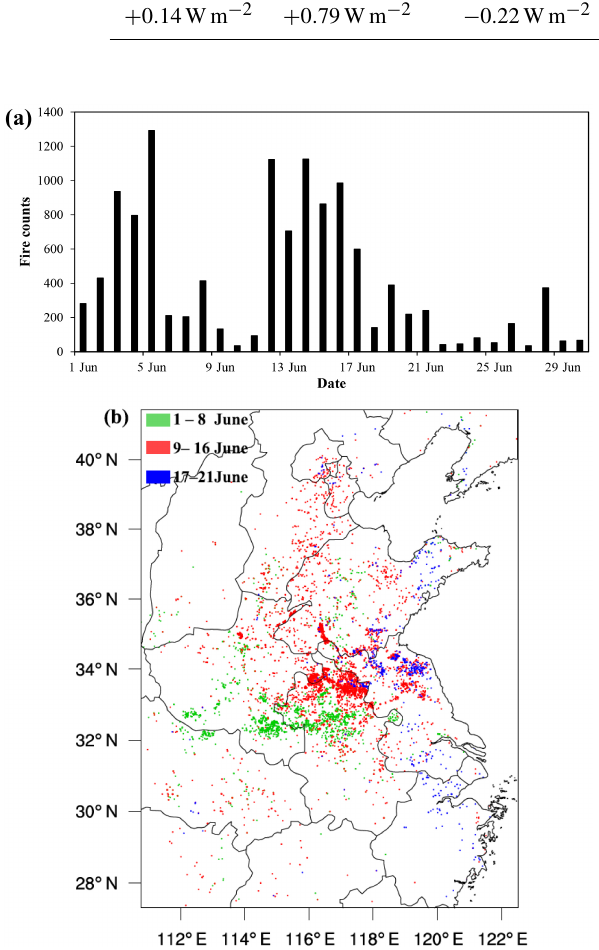
Figure 2. (a) Time series of the fire counts detected by the Moder- ate Resolution Imaging Spectroradiometer (MODIS) in East China in June 2013. (b) Spatial distribution of MODIS agricultural fire counts in East China in June 2013. The green, red and blue dots represent the location of fire counts detected in 1–8, 9–16 and 17– 21 June, respectively.